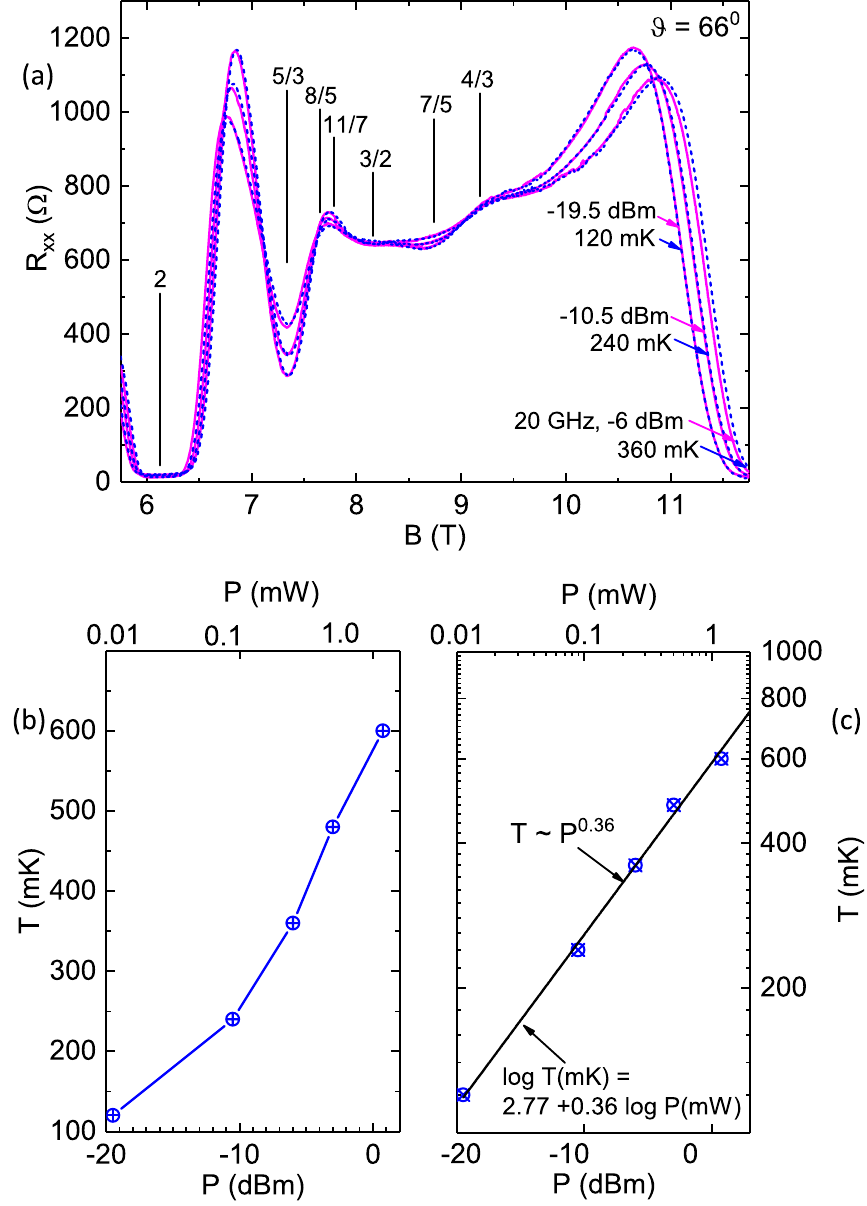
Figure 7. Overlay of power- and temperature- traces of R xx vs . B and the extraction of the carrier temperature at a given microwave power. ( a ) R xx vs. B traces obtained at various P at base temperature, have been overlaid upon the dark R xx vs. B traces obtained at some temperatures, T . The results suggest excellent registry between the power and temperature traces. ( b ) The carrier temperature ( T ) at different microwave power ( P ), which has been extracted by matching up power traces with temperature traces, as in the top panel. ( c ) A log-log plot suggests simple power law behavior with T ≈ P 0.36